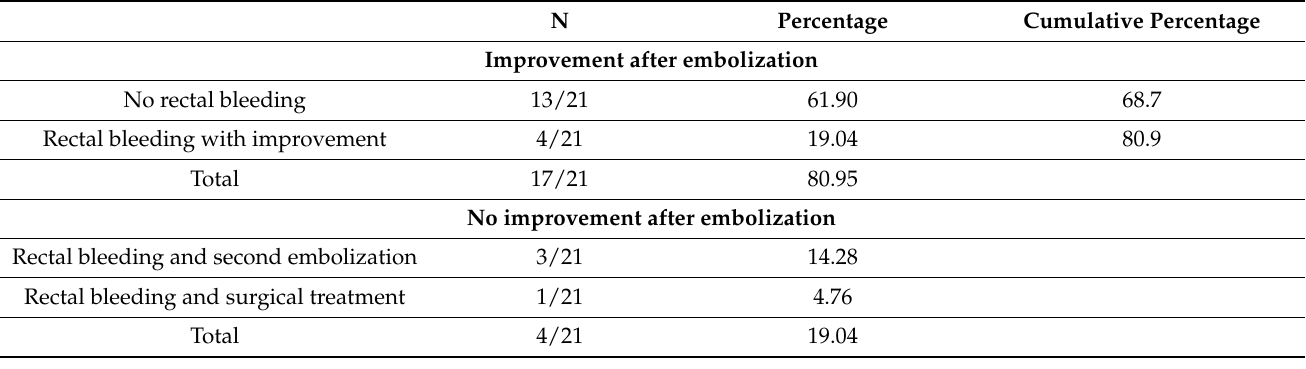
Table 2. Immediate results after embolization.